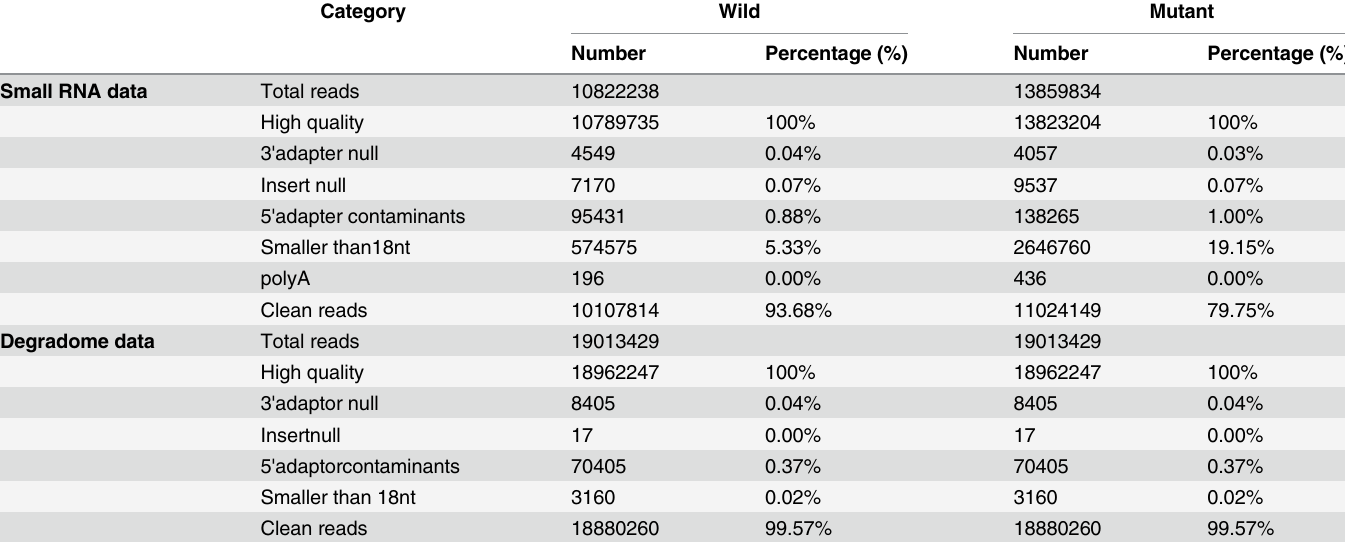
Table 2. Data set summary of sequencing of two (wild and mutant strain) small RNA and degradome libraries.